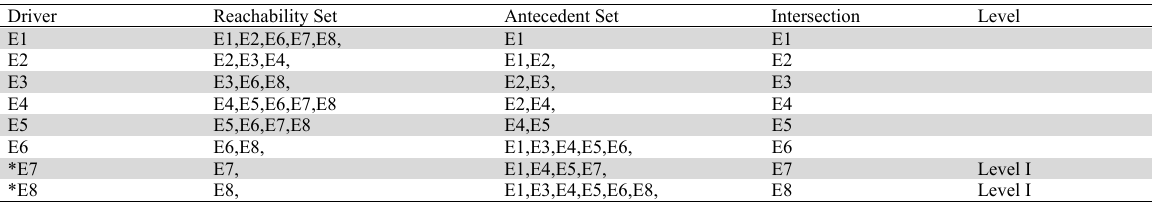
Level Partition-iteration